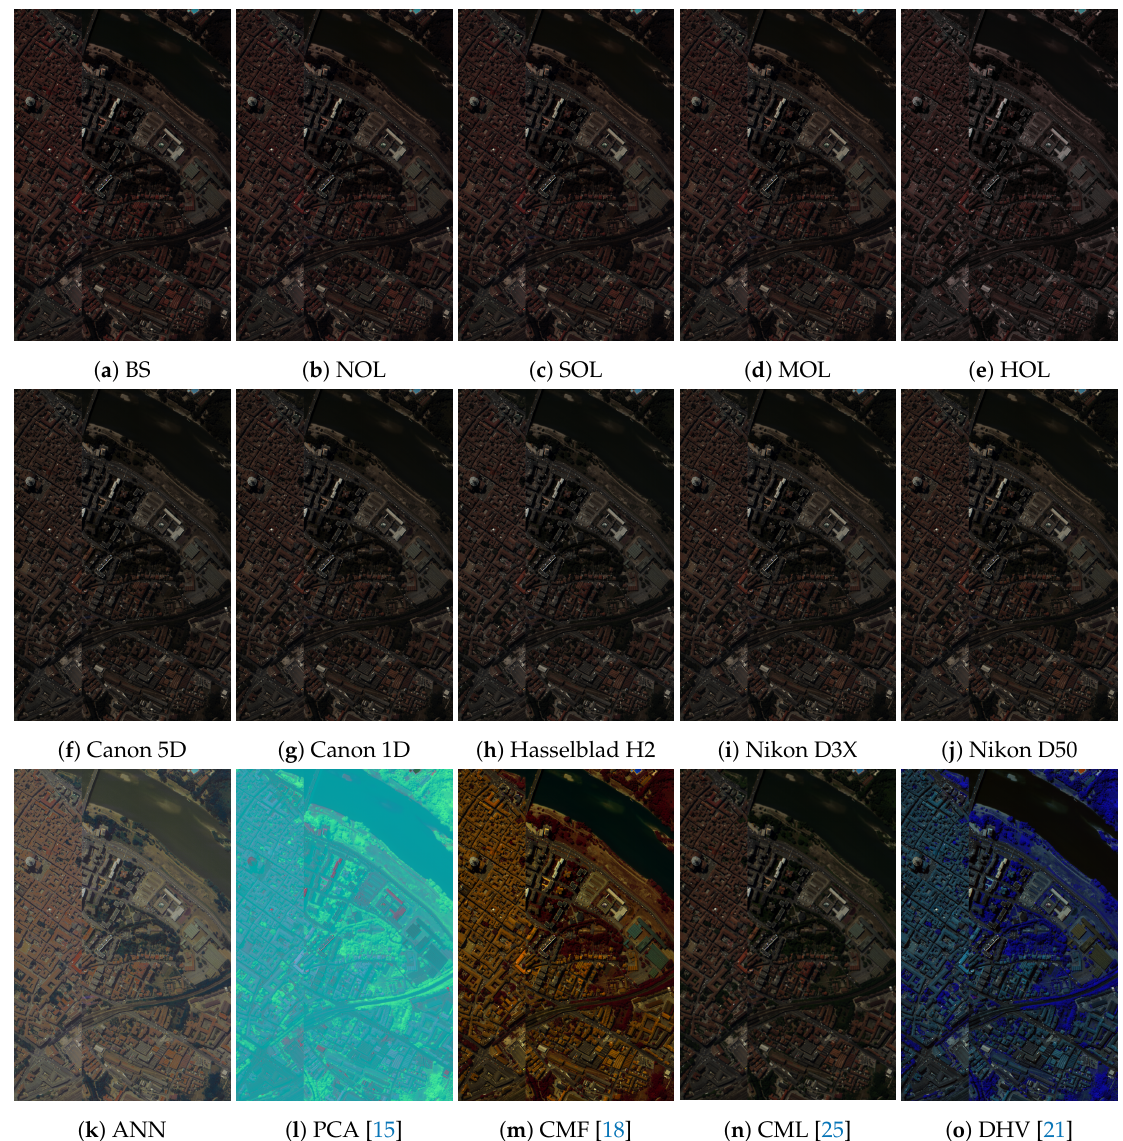
Figure 10. Experimental results on the Pavia Centre image. ( a ) BS. ( b ) NOL. ( c ) SOL. ( d ) MOL. ( e ) HOL. ( f ) Canon 5D. ( g ) Canon 1D. ( h ) Hasselblad H2. ( i ) Nikon D3X. ( j ) Nikon D50. ( k ) ANN. ( l ) PCA